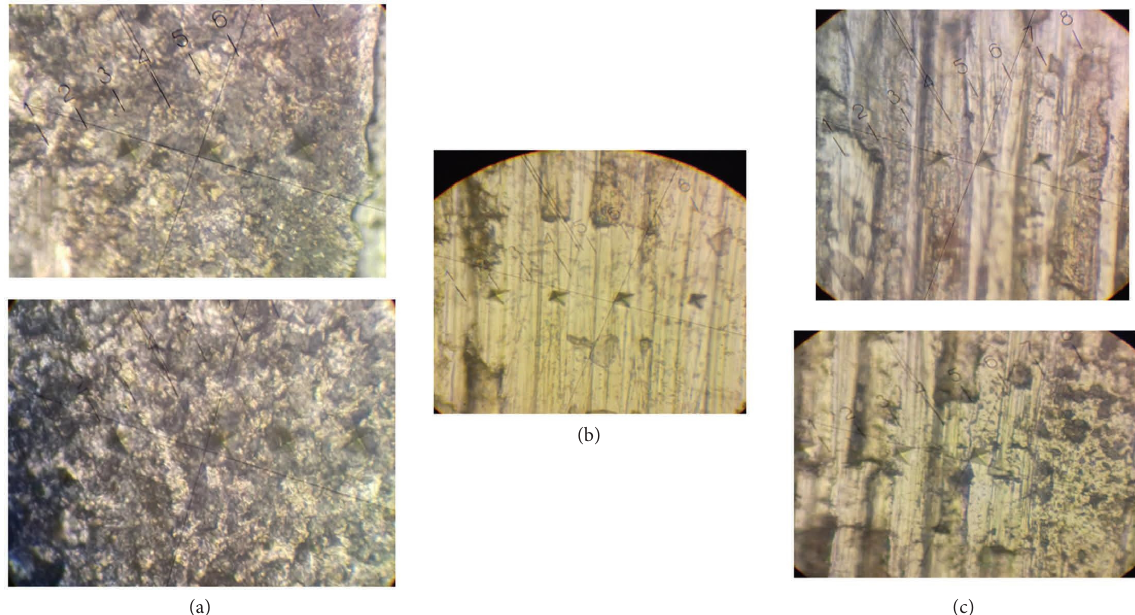
Figure 8: Photographs of areas of frictional contact: (a) when lubricated with lubricant sample 1, (b) the starting surface, and (c) when lubricated with lubricant sample 2.